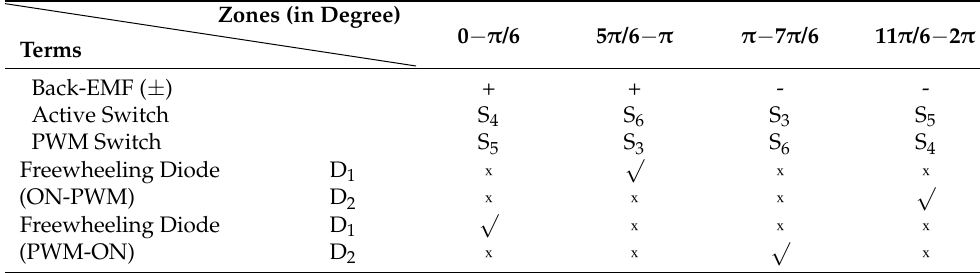
Table 1. Switching pattern before and after the commutation zone. Zones (in Degree)